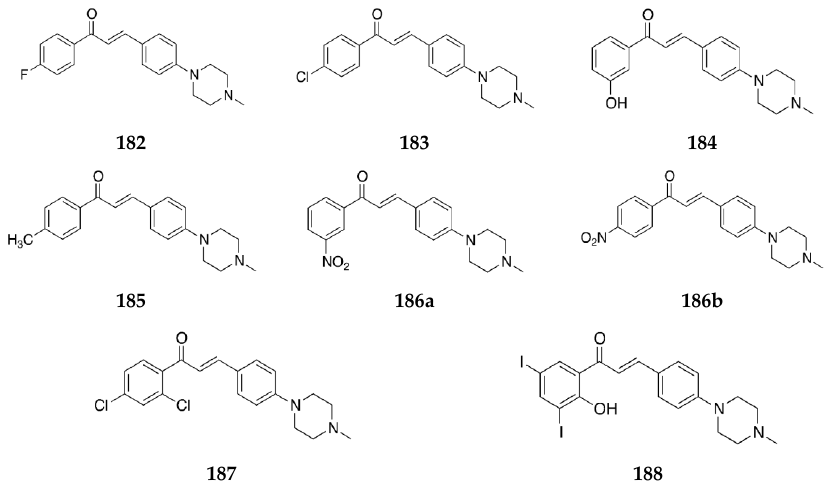
Figure 61. Chemical structure of methyl piperazine-substituted 4′-aminochalcone derivatives. Compounds 182 – 188 were tested for their antibacterial activity against Escherichia coli , Staphylococcus aureus , Salmonella typhi , and Bacillus subtillis and for their antifungal activity against Aspergillus niger , Aspergillus flavus , Penicillium chrysogenum , and Candida albicans strains, summarized in Table 27 with dimethyl sulfoxide (DMSO) used as the solvent control. Table 27. Antimicrobial activity of 182 – 188 against Escherichia coli, Staphylococcus aureus, Salmonella typhi, Bacillus subtillis, Aspergillus niger, Aspergillus flavus, Penicillium chrysogenum, and Candida albicans strains, expressed as the zone of inhibition in mm. Compound